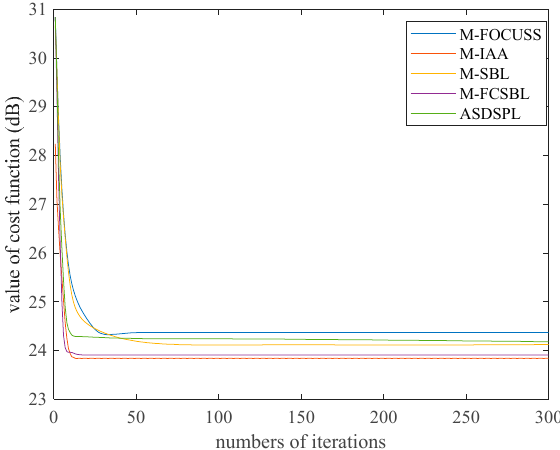
Figure 6. Value of cost function to the number of iterations.